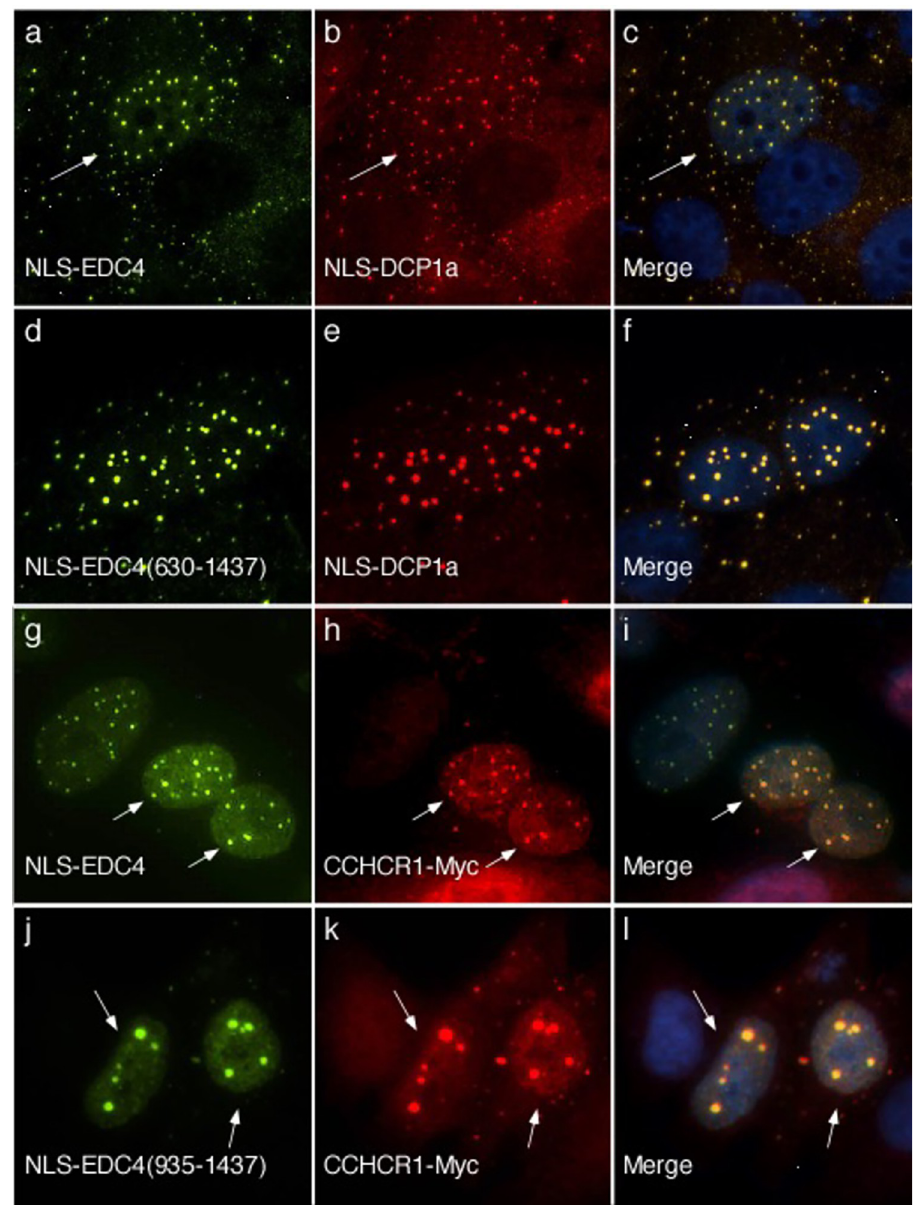
Fig 5. The N-terminus of EDC4 is not required for interaction with DCP1a. Co-expression of NLS-EDC4 (panel a) and NLS-DCP1a (panel b) resulted in co-localization of the proteins to nuclear dots (panel c) in all cells that had both proteins in the nucleus. White arrows in a-c indicate a representative cell containing both NLS-EDC4 and NLS-DCP1a in nuclear dots. GFP-NLS-EDC4(630–1437) (panel d) was also able to recruit NLS-DCP1a (panels e, f) to nuclear dots in all cells that expressed both proteins. The C-terminus of EDC4 is sufficient to mediate interaction with CCHCR1. Co-expression of NLS-EDC4 (panel g) and CCHCR1-Myc (panel h) resulted in co-localization of the proteins in nuclear dots (panel i) in all cells that expressed both proteins. The C-terminus of EDC4 (GFP-NLS-EDC4(935–1437)) (panel j) was sufficient to recruit CCHCR1-Myc (panels k, l) to nuclear dots. CCHCR1-Myc co-localized with GFP-NLS-EDC4(935–1437) in 96+/-4% of cells expressing both proteins. White arrows indicate the location of representative cells that expressed NLS-EDC4 and CCHCR1-Myc (g-i) and NLS-EDC4(935–1437) and CCHCR1-Myc (j-l). Human serum was used to detect NLS-EDC4 in a and g. Rabbit antiserum was used to detect NLS-DCP1a in b and e. Rabbit anti-Myc antiserum was used to detect CCHCR1-Myc in h and k. Mouse monoclonal anti-GFP antibody detected GFP-NLS-EDC4(630–1437) and GFP-NLS-EDC4(935–1437) in d and j respectively. Merge of panels a and b, d and e, g and h, and j and k is shown in c, f, i and l respectively. DAPI staining (blue) indicates the location of nuclei in c, f, i and l.